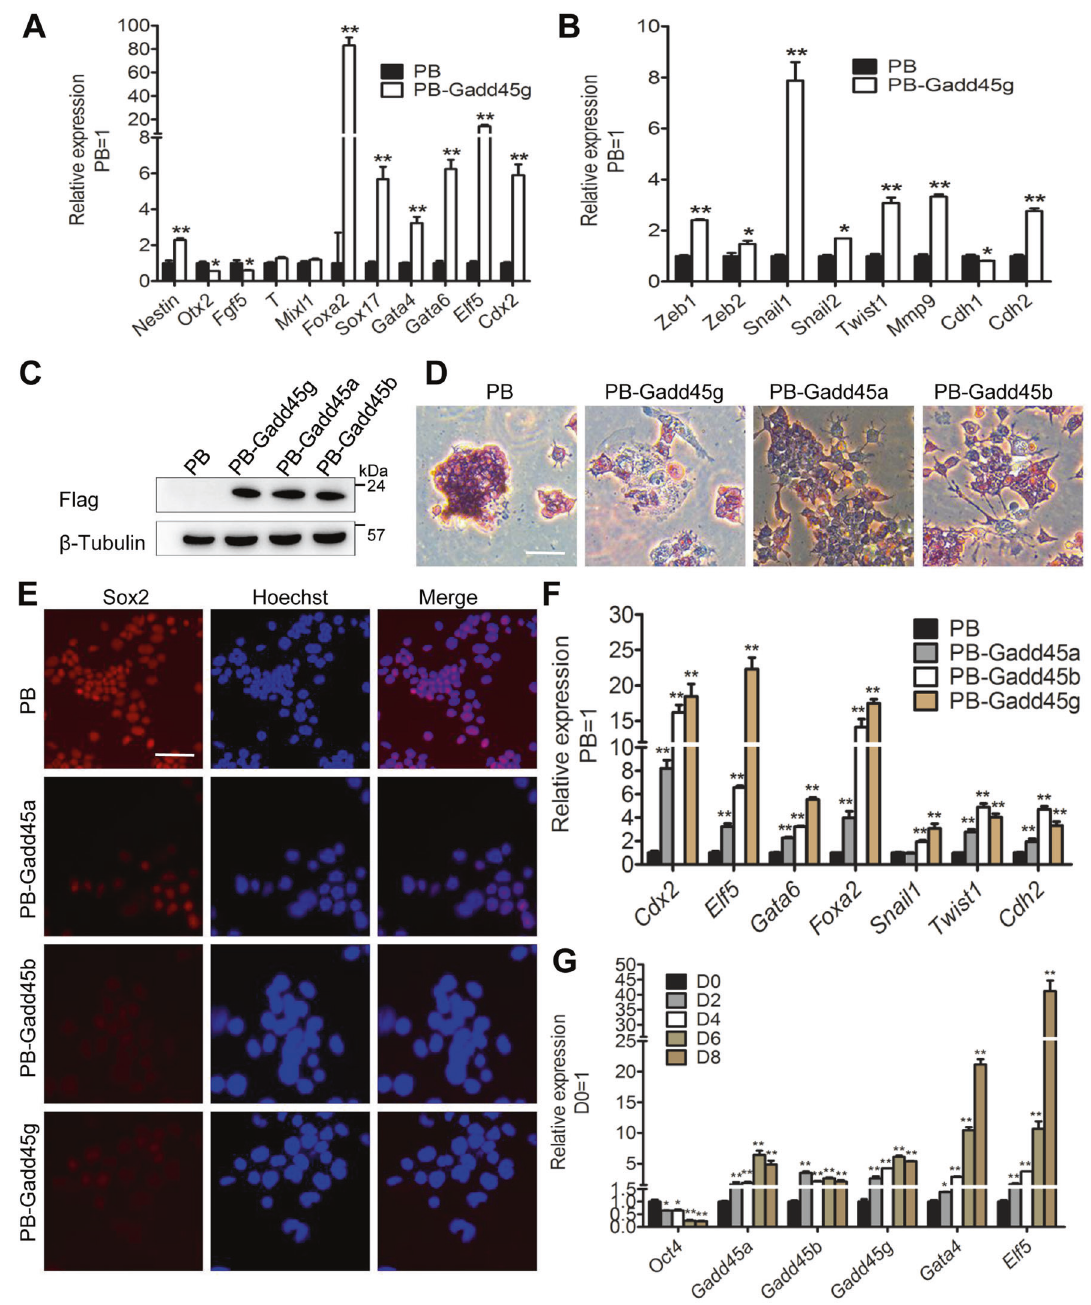
Fig. 2 Overexpression of Gadd45 genes triggers lineage differentiation in mESCs. A qRT-PCR analysis of the expression of speci fi c markers of different germ layers in PB and PB-Gadd45g 46 C mESCs. The data are represented as the means ± s.d. ( N = 3 biological replicates). * p < 0.05, ** p < 0.01 vs PB. B qRT-PCR analysis of the expression of epithelial-mesenchymal transition (EMT) marker genes in PB and PB-Gadd45g 46 C mESCs cultured in LIF/serum condition. The data are represented as the means ± s.d. ( N = 3 biological replicates). * p < 0.05, ** p < 0.01 vs PB. C Western blot analysis of FLAG in 46 C mESCs overexpressing FLAG-tagged mouse Gadd45 family genes (PB-Gadd45a, PB-Gadd45b, PB- Gadd45g) or PB. β -tubulin was used as a loading control. D AP staining of PB, PB-Gadd45a, PB-Gadd45b, and PB-Gadd45g 46 C mESCs cultured in LIF/serum-containing medium for 2 passages. Bar, 100 μ M. E Immuno fl uorescence of pluripotency gene Sox2 in PB, PB-Gadd45a, PB- Gadd45b, and PB-Gadd45g 46 C mESCs. Bar, 100 μ M. F qRT-PCR analysis of the expression of differentiation genes and EMT markers in PB, PB- Gadd45a, PB-Gadd45b, and PB-Gadd45g mESCs cultured in LIF/serum condition. The data are represented as the means ± s.d. ( N = 3 biological replicates). ** p < 0.01 vs PB. G qRT-PCR analysis of mouse Oct4, Gadd45a, Gadd45b, Gadd45g, Gata4, and Elf5 expression levels in 46 C mESCs- derived EBs collected from different days. The data are represented as the means ± s.d. ( N = 3 biological replicates). * p < 0.05, ** p < 0.01 vs D0. D0, Day 0.